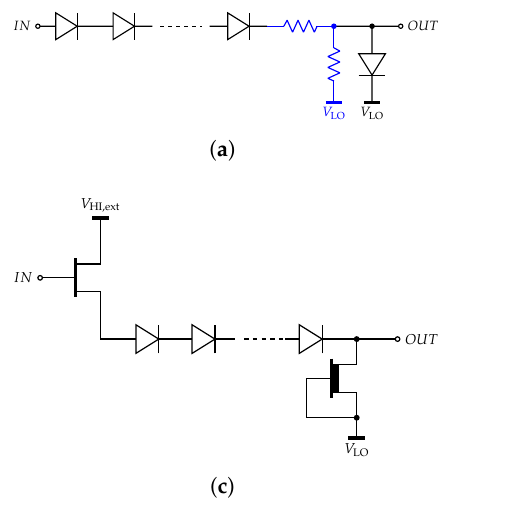
Figure 5. Input level shifters: ( a ) Basic level shifter with optional (blue) series/shunt resistors, adopted for example in [15,22,31]. ( b ) Level shifter with common source buffer, adopted for example in [15]. ( c ) Level shifter with source follower buffer, adopted for example in [19]. Note that in all schemes diodes can be replaced by diode-connected